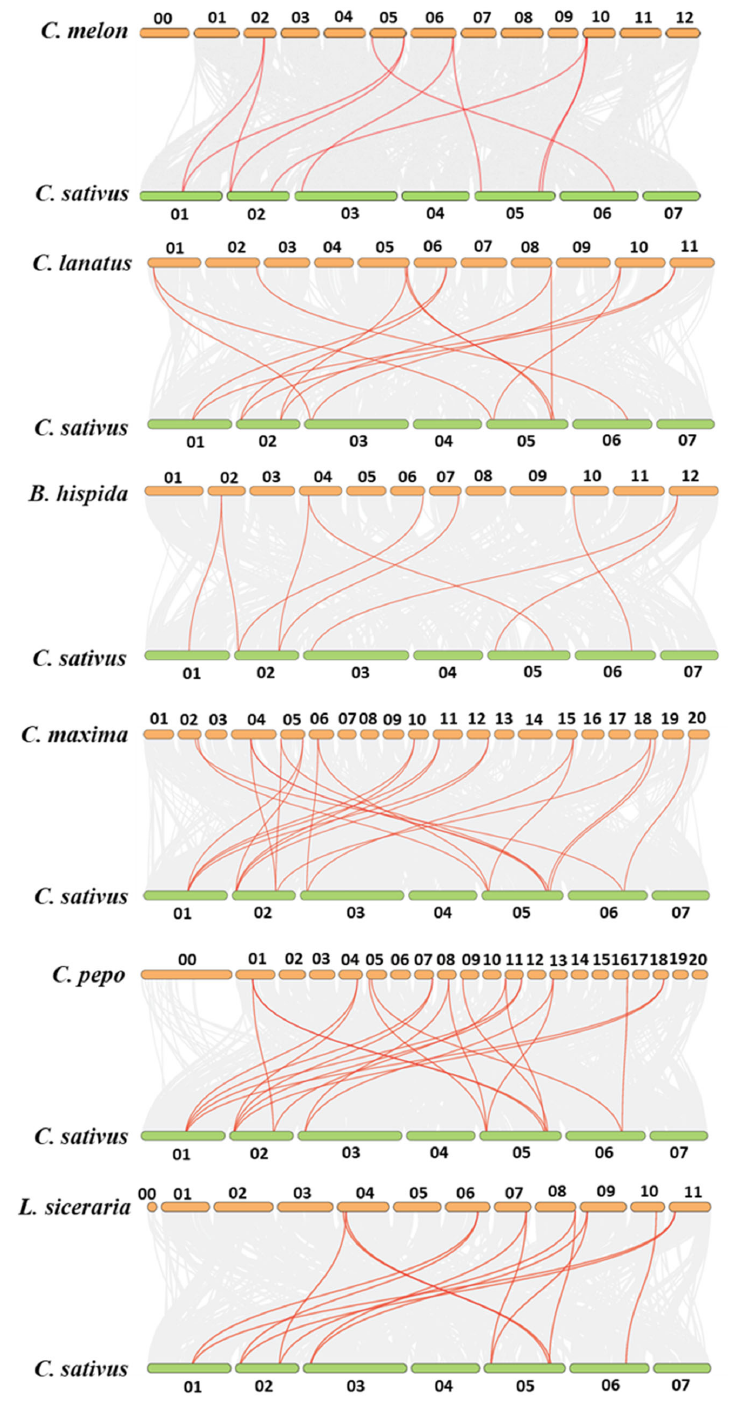
Figure 2. Synteny analysis of YABBY genes between cucumber and melon, watermelon, wax gourd, pumpkin, zucchini, and bottle gourd. The synteny gene pairs are highlighted in the red lines.